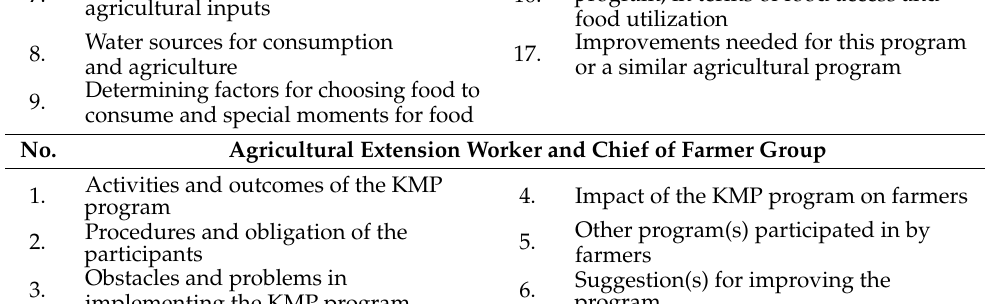
Table 2. HDDS thresholds proposed by IFPRI.